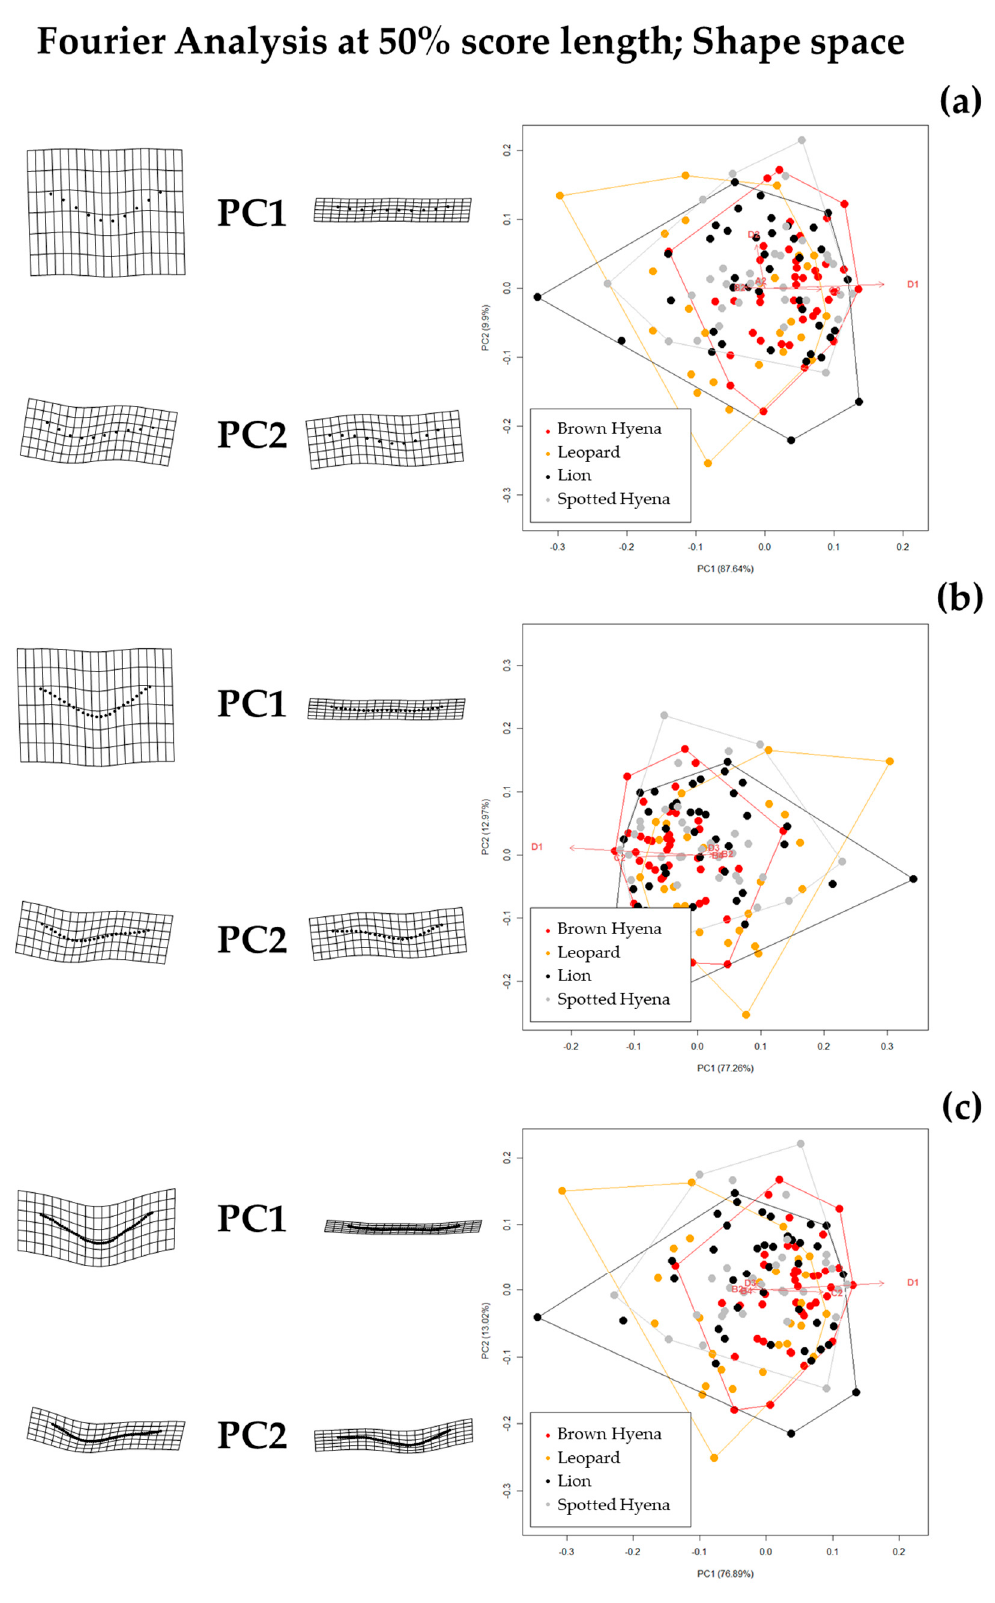
Figure 4. Shape PCA plots on Elliptic Fourier Analysis on the single-curve semilandmark models at 50% cross-sectional score length, using ( a ) 10 points; ( b ) 25 points; and ( c ) 50 points. Extreme changes in shape along PC1 and PC2 are illustrated with the aid of transformation grids. Optimal harmonics for each model are ( a ) 2; ( b ) 6; and ( c ) 6.